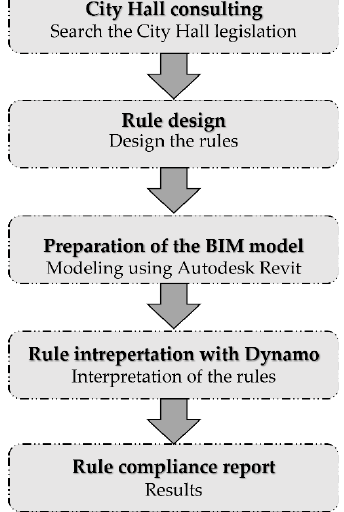
Figure 2. Research